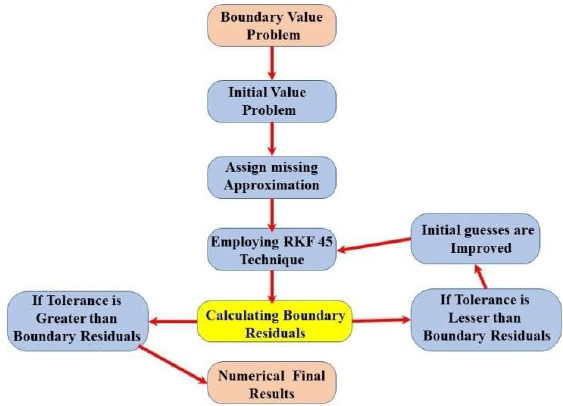
Figure 2. Structural outline for the numerical procedure.